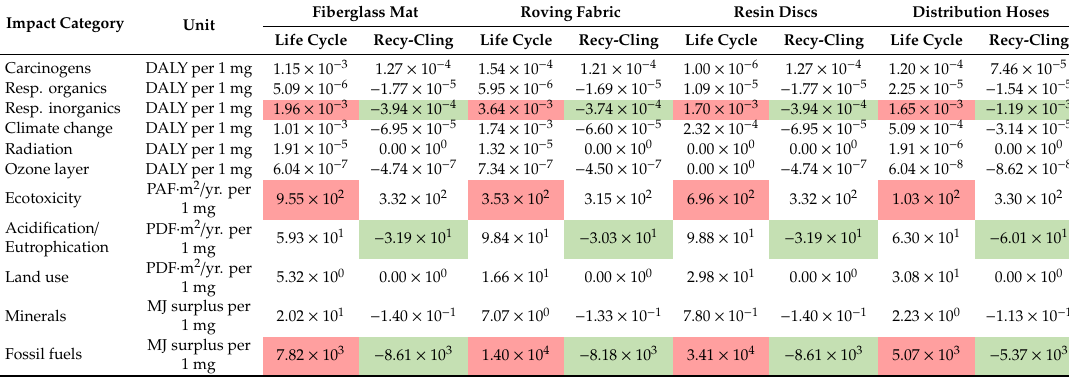
Red highlight—the highest level of negative environmental consequences for a given unit. Green highlight—the highest level of positive environmental consequences for a given unit. Table 3. Characterization results of environmental consequences occurring in the life cycle of selected postproduction waste of wind power plant blades—part 2.